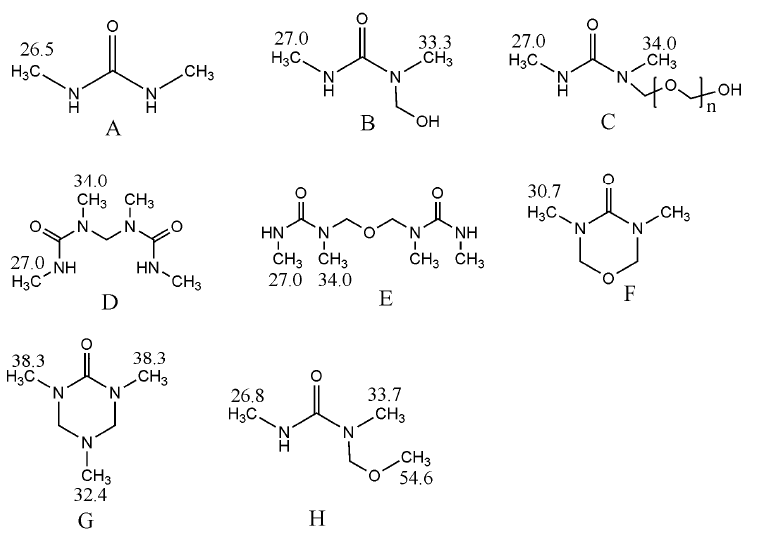
Figure 1. The possible products formed in DMUF reactions.